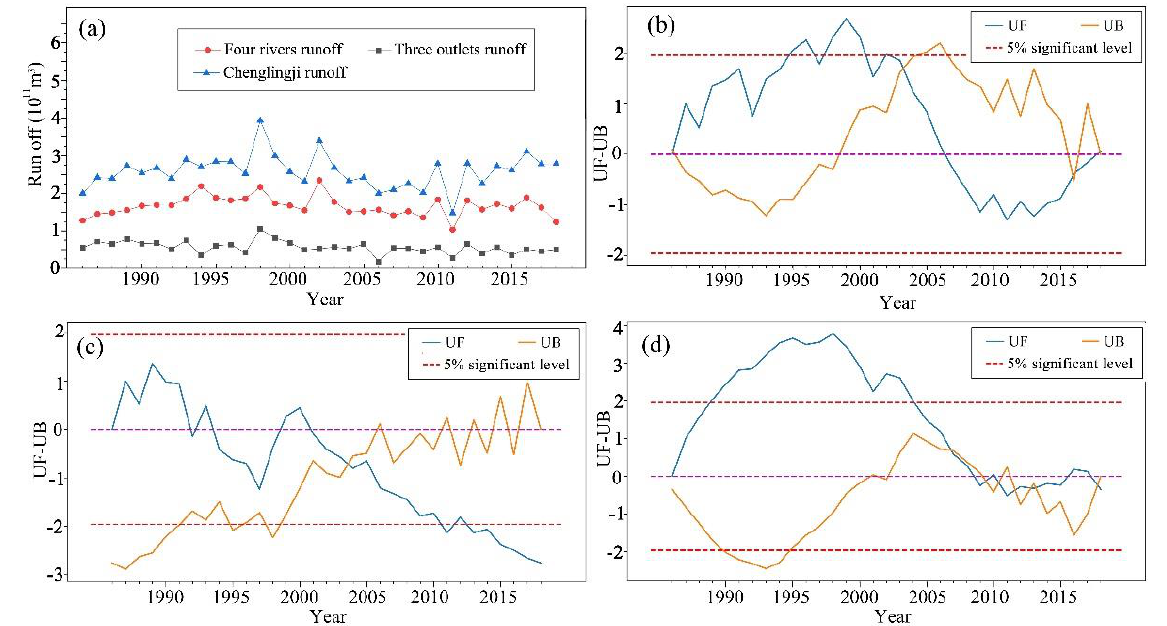
Figure 7. Change in runoff from 1986 to 2018: ( a ) Runoff curves; ( b ) M-K test result of Chenglingji runoff; ( c ) M-K test result of three outlets runoff; and ( d ) M-K test result of four rivers runoff.